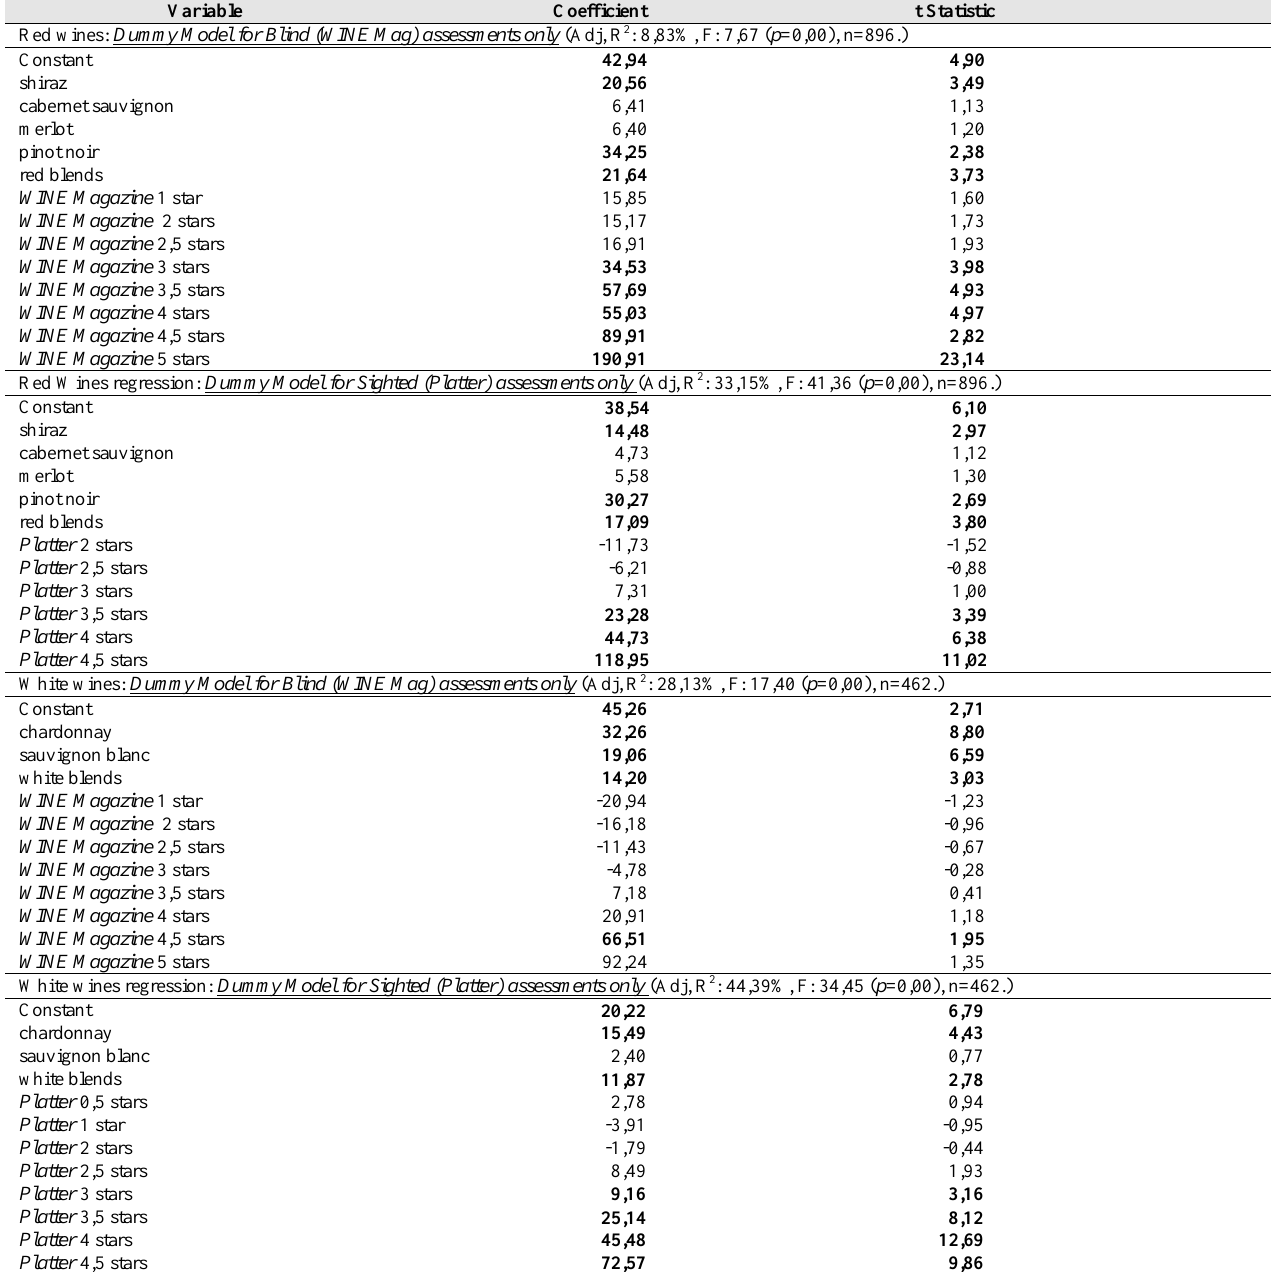
Table 3: Red and white wines 2007: estimated dummy model regressions for blind and sighted metrics. Note: significant t -stat figures and their respective coefficients are cited in bold. Sighted valuations attract higher adjusted R 2 values than blind